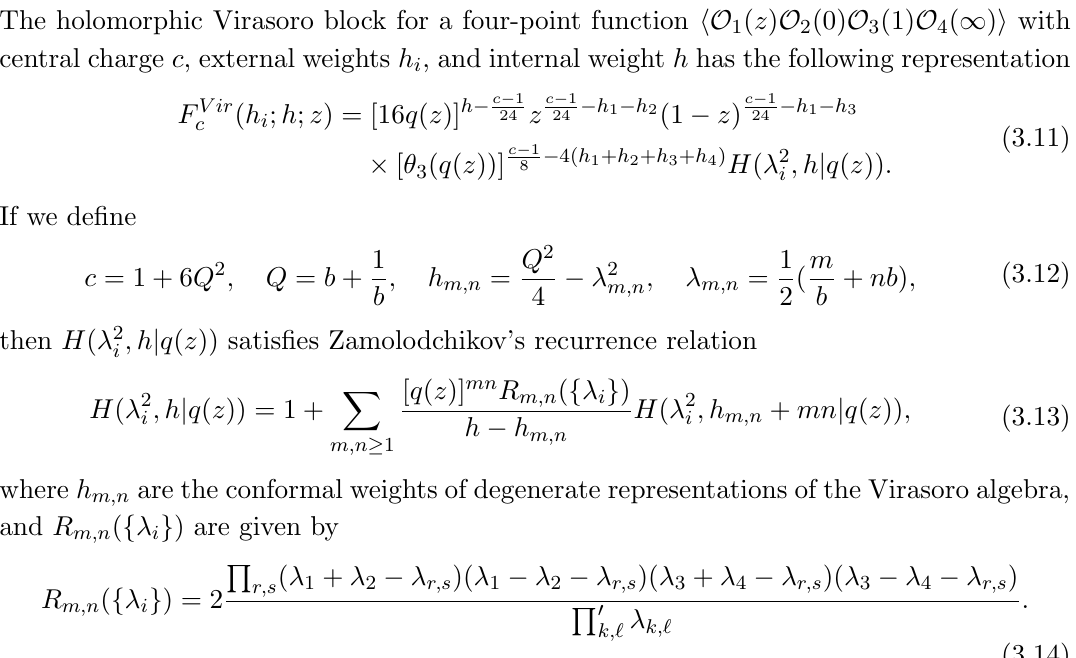
Figure 3. Relation between Virasoro